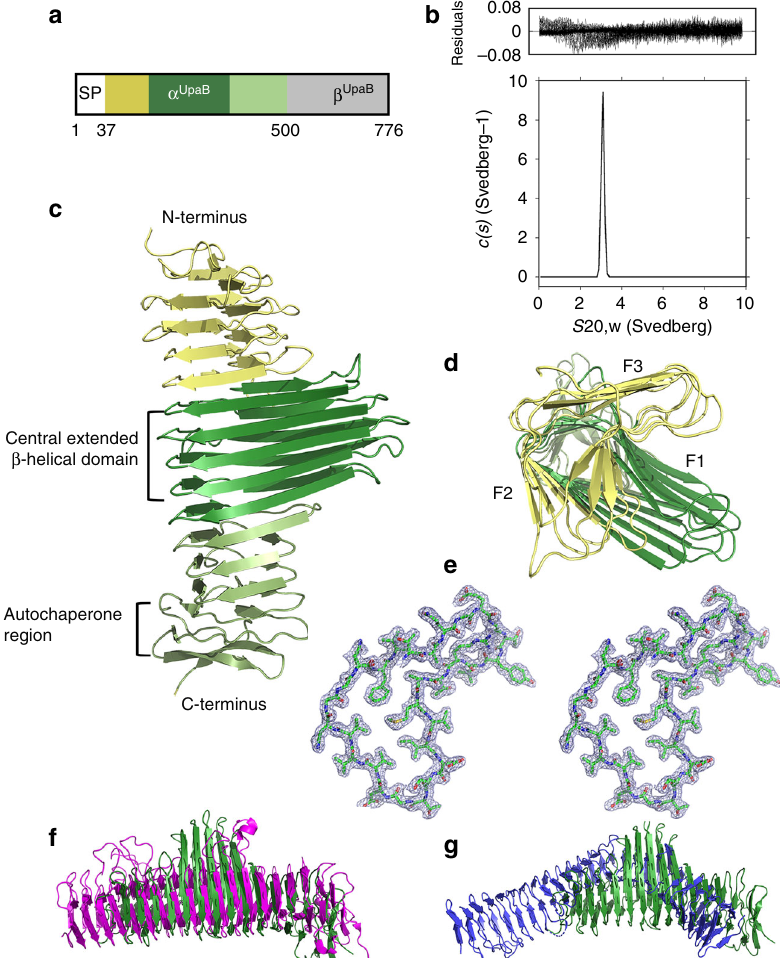
Fig. 1 The structure of the UpaB functional α -domain ( α UpaB ). a Domain organisation of UpaB comprising an N-terminal signal sequence (SP; residues 1 – 37), an α -domain ( α UpaB ; residues 38 – 500) and a β -domain ( β UpaB ; residues 501 – 776). b Analytical ultracentrifugation sedimentation velocity analysis of α UpaB . The continuous standardised sedimentation distribution [ c ( s )] shows that UpaB at 2.2 mg ml − 1 exists as a 3.1 s 20,w monomer. c Cartoon representation of the α UpaB structure, including d top view. The central domain consisting of extended β -strands is shown in dark green. The N-terminal and C-terminal β -helical domains are shown in yellow and light green, respectively. The top view has F1, F2 and F3 faces shown. e Stereo view of the 2 F o − F c electron density map contoured at 1 σ of the cross-section of the α UpaB β -helix. Structural comparison of UpaB (green) with the α -domain of f pertactin (from B. pertussis ; magenta; PDB 1DAB) and g Ag43a (from UPEC; blue; PDB